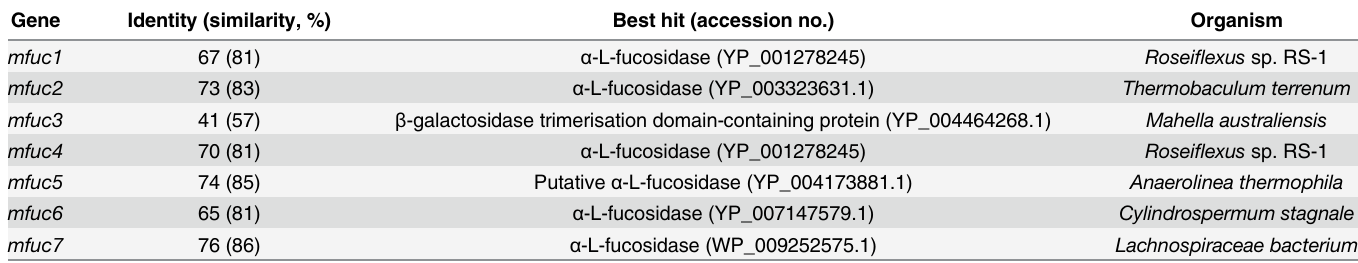
Table 1. BLASTp analysis of metagenome-derived protein sequences. Gene Identity (similarity,